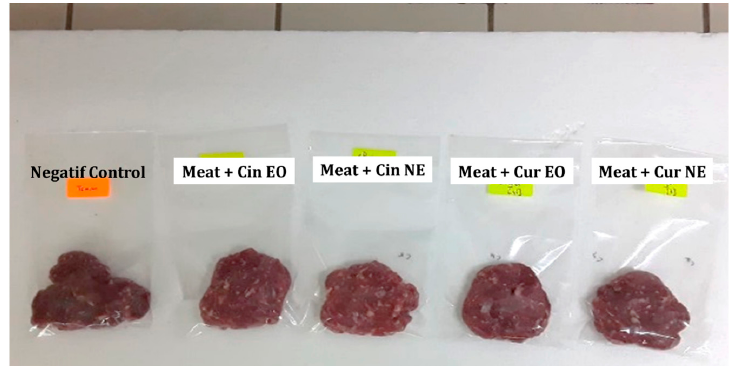
Photo 1. Visual aspects of minced meat (negative control) and minced meat treated with cinnamon essential oil (Cin EO), cinnamon nanoemulsion (Cin NE), curcuma essential oil (Cur EO) and curcuma nanoemulsion (Cur NE) after 24 h of